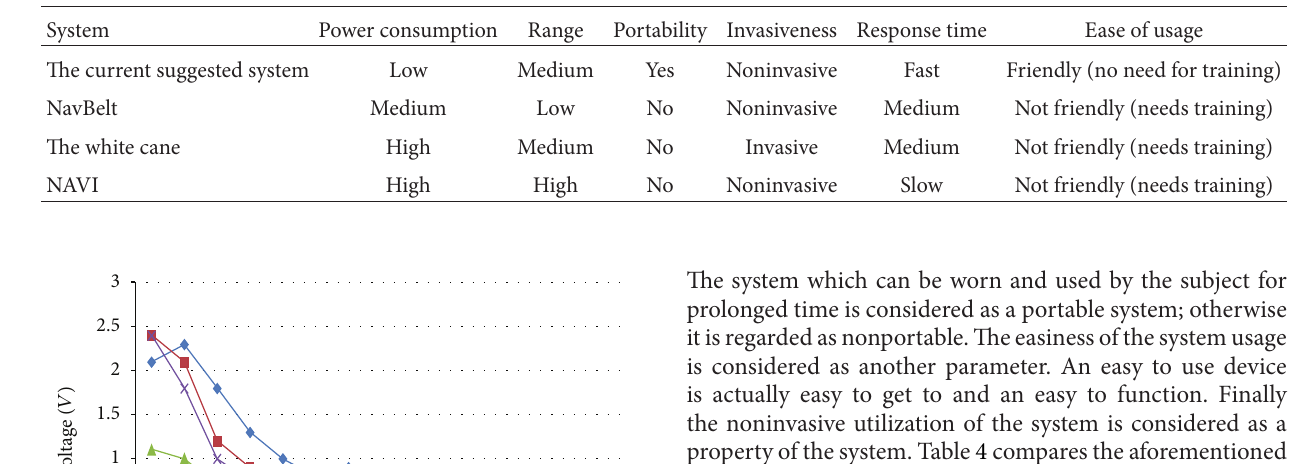
Table 4: Comparison of different devices.